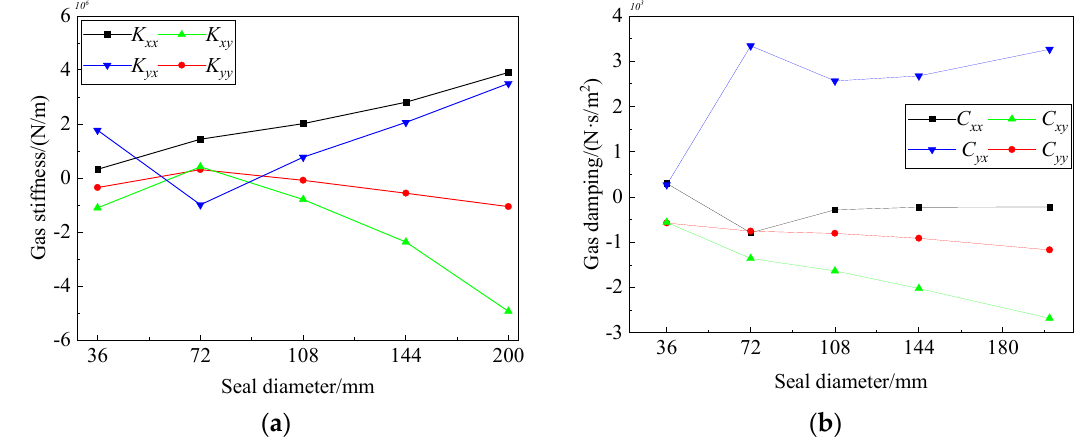
Figure 5. The effect of seal diameter on the rotodynamic coefficients. ( a ) The effect of seal diameter on gas stiffness; ( b ) The effect of seal diameter on gas